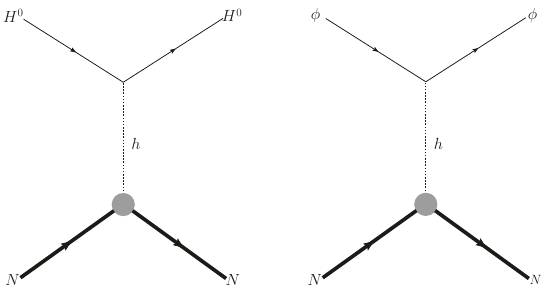
Figure 9 . Spin independent direct detection processes for IDM (left) and scalar singlet DM (right).